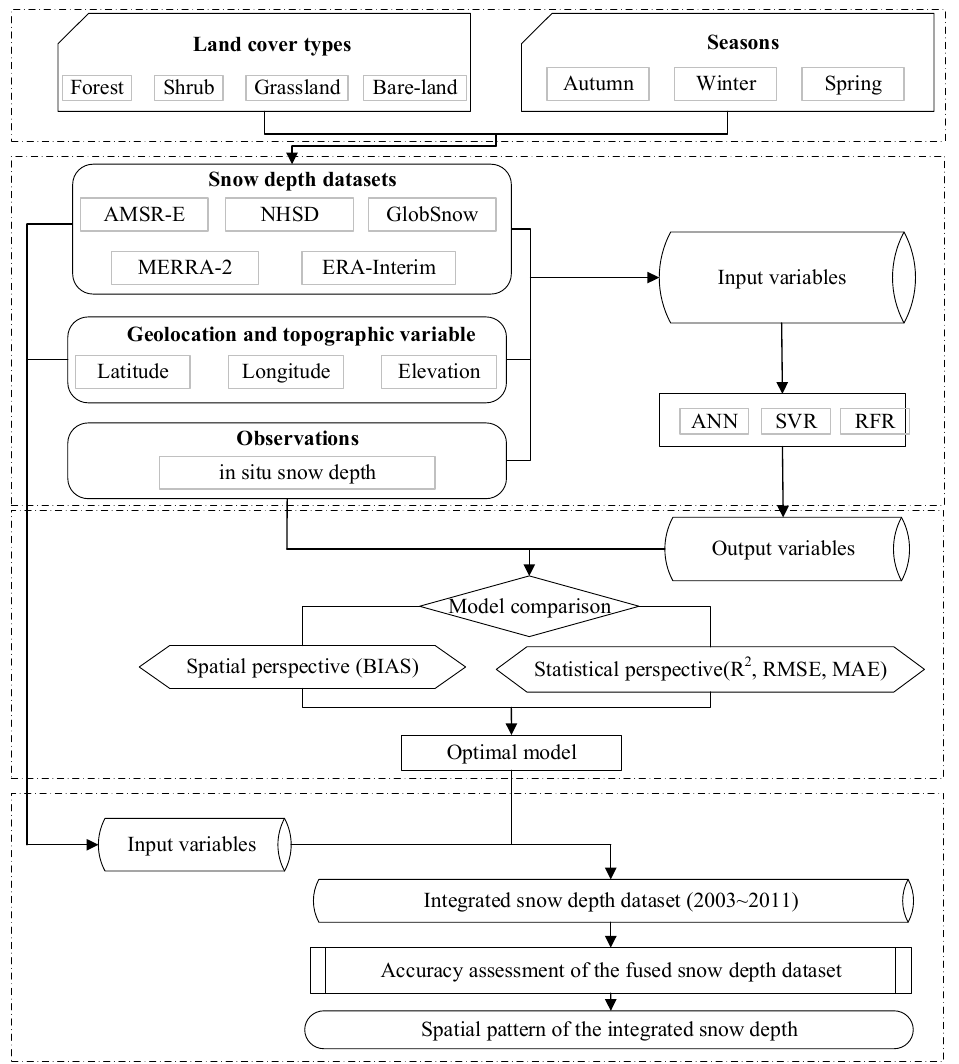
Figure 2. Flowchart of the proposed fusion approach for estimating snow depth over the Northern Hemisphere.